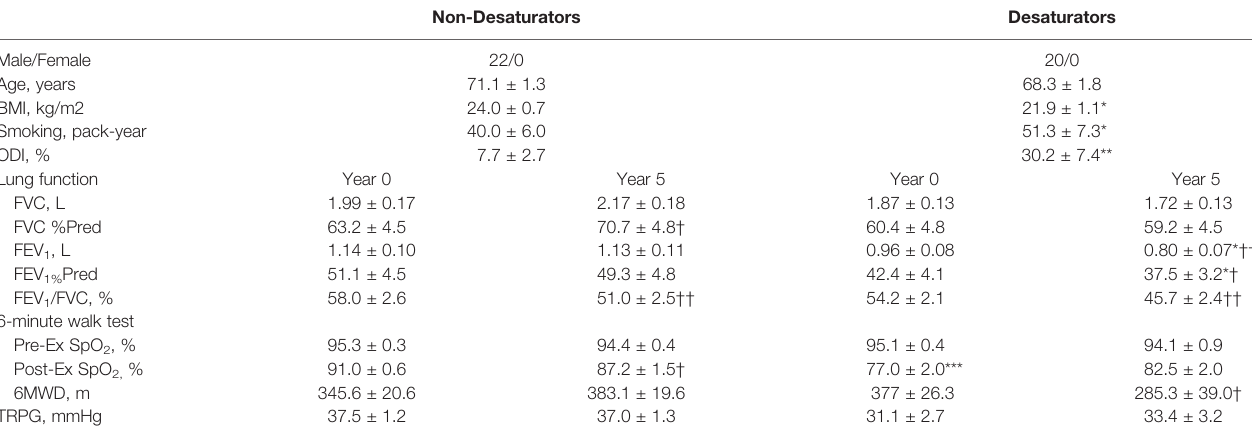
TABLE 1 | Clinical characteristics of study